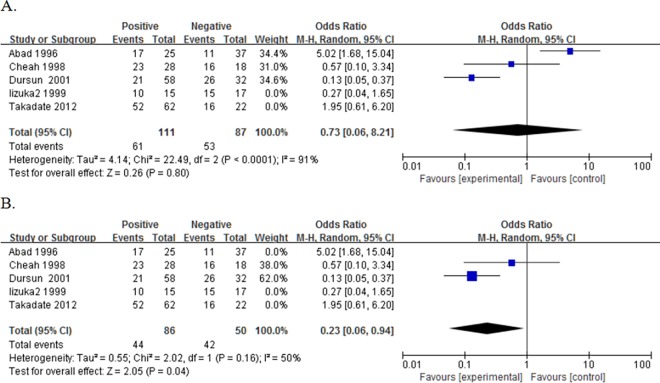
Forest plot of odds ratio (OR) for the association between NME1 overexpression and disease-free survival (DFS) in patients with different tumor types with random effects model.A. The ORs for DFS; B. The new ORs for DFS.